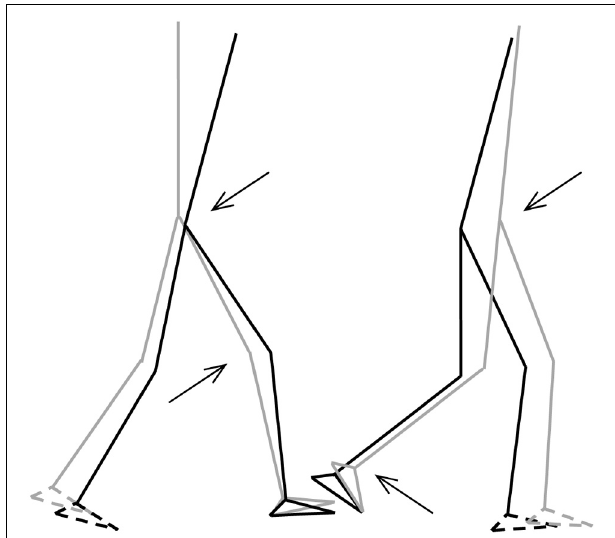
FIGURE 5 | Stick-figures of the body configuration at initial FS (left) and TO (right). Gray lines represent the TD-children without DCD, black lines represent the children with DCD. Feet with broken lines are the contralateral feet. Arrows indicate significant differences of the joint angles ( p < 0 . 05) (from Deconinck,